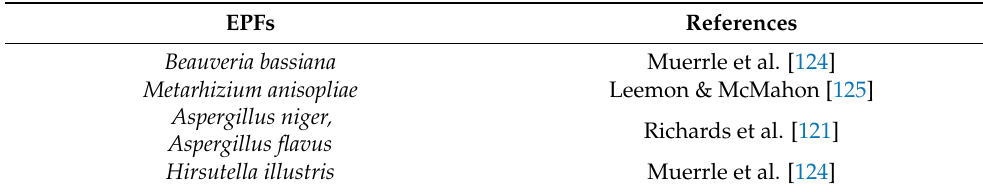
Table 2. Entomopathogenic fungi (EPFs) active versus A. tumida